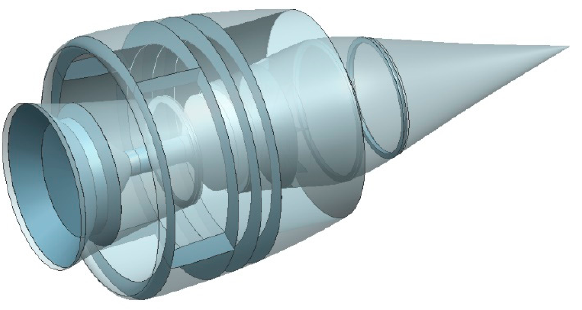
Figure 22. Basic visualization of CENTRELINE aft-fuselage aero-structural integration concept.